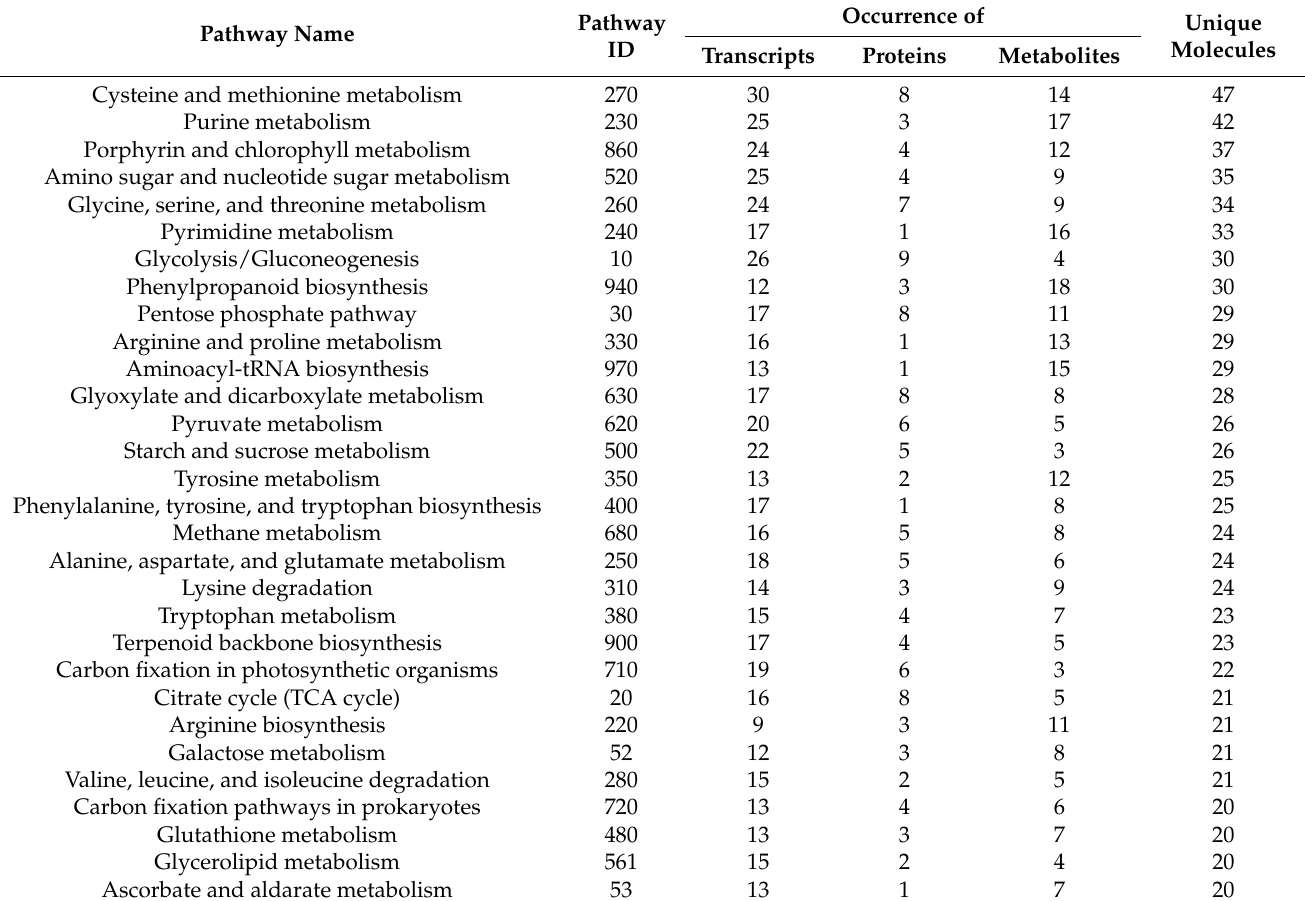
Table 2. List of the pathways most affected by drought stress—number of unique molecules—obtained via Multi-Omics Integration (MOI). Transcriptomics, proteomics, and metabolomics data from leaves of young oil palm plants 14 days after imposition of the treatments (control and water